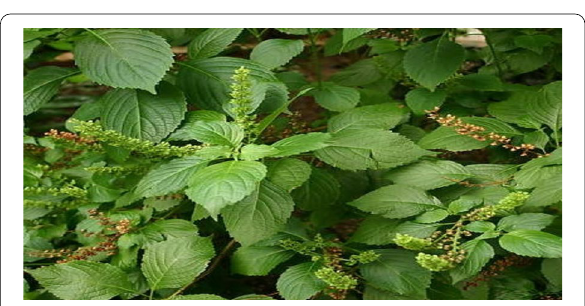
Fig. 3 Ocimum Gratissimum plant (Scent leaf). Source